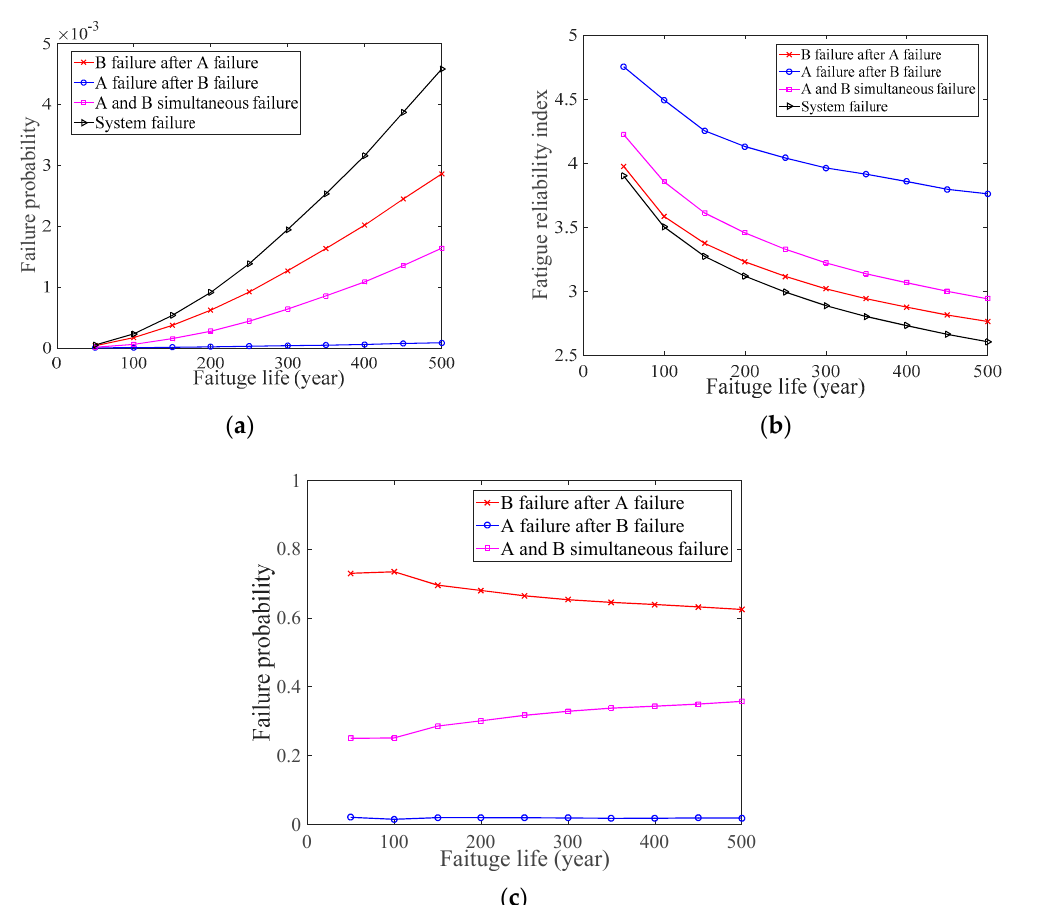
Figure 4. Numerical case study 3. ( a ) Fatigue probability of the welds and system; ( b ) Fatigue reliability index of the welds and system; ( c ) Bayesian inference.